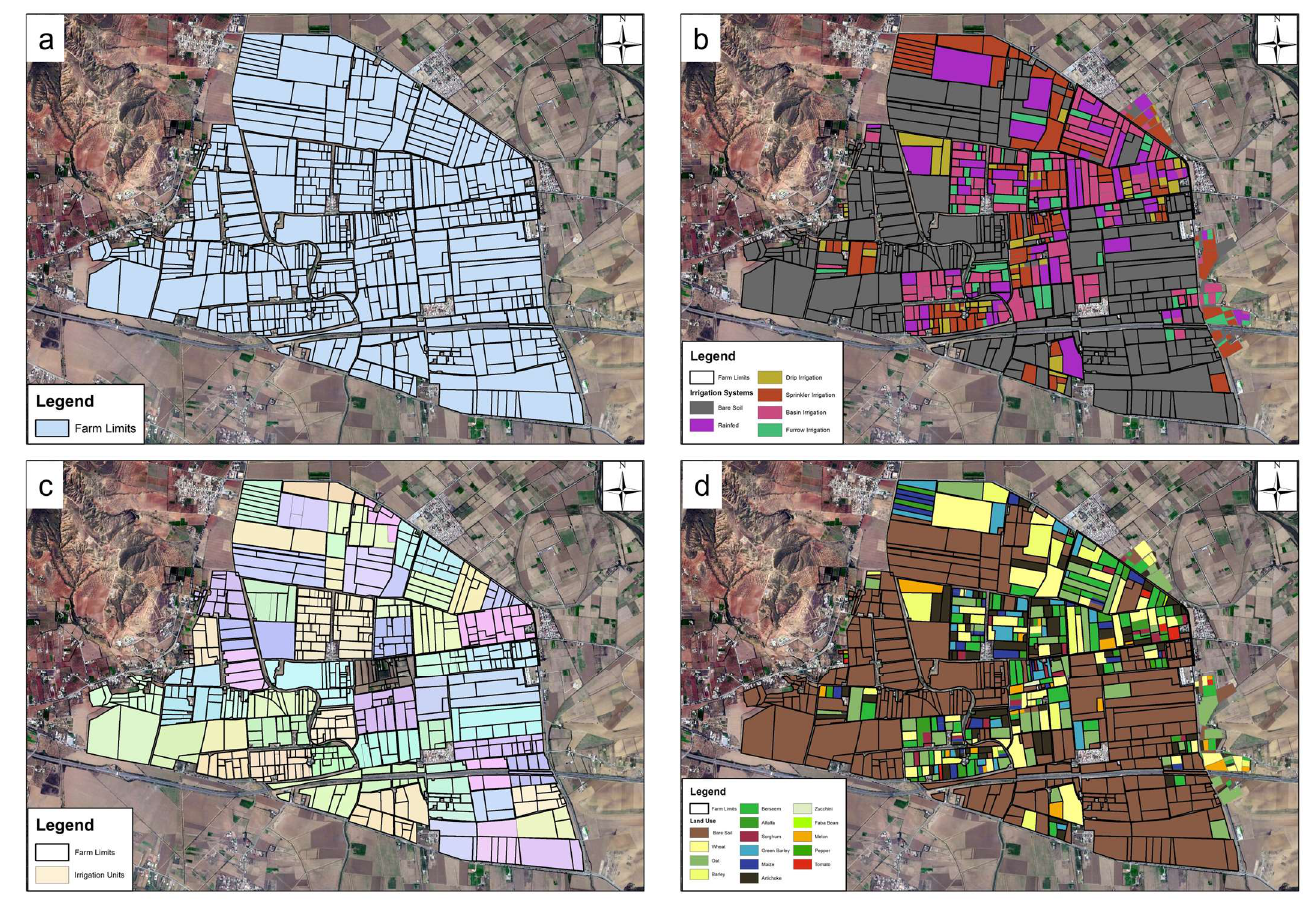
Figure 3. Thematic maps of the Cherfech irrigated district ( a ) farm limits; ( b ) used irrigation system; ( c ) hydraulic units; and ( d ) land use during the growing season.